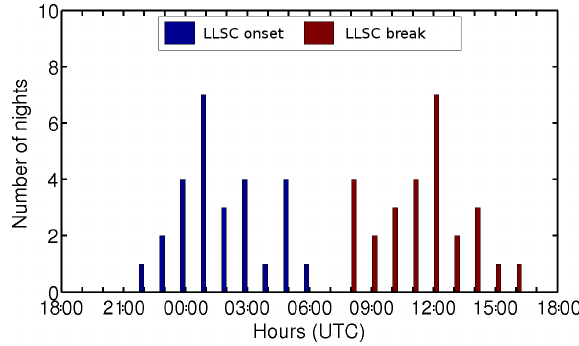
Figure 11. Distribution of (blue) onset and (brown) breakup times of LLSCs at Savè from the period of 20 June through 30 July 2016.